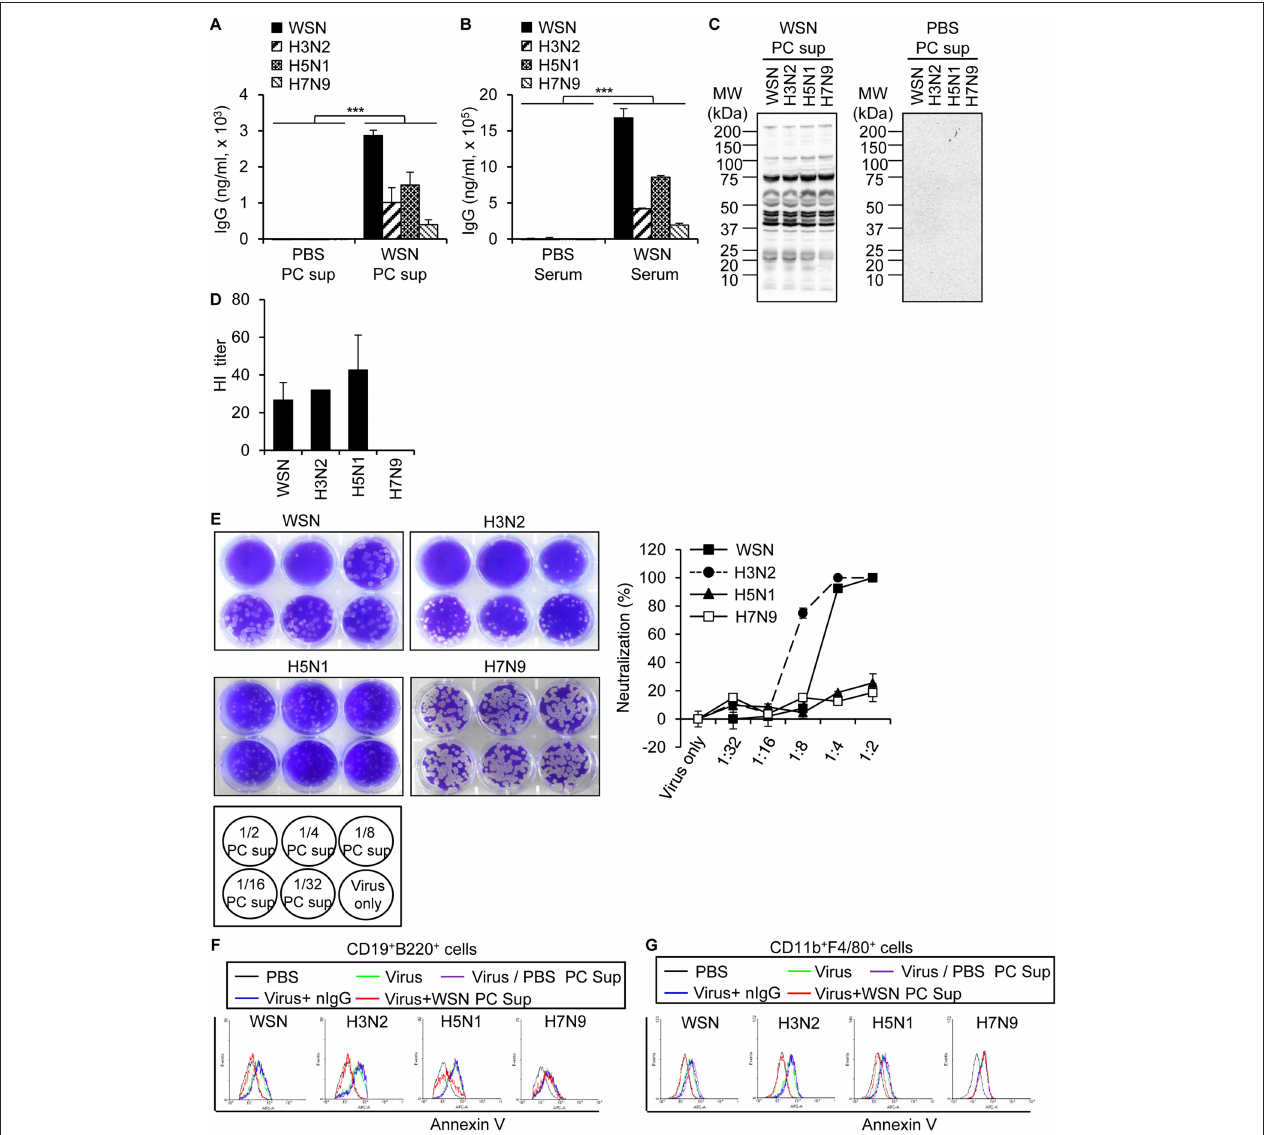
FIGURE 6 | Cross reactivity of A/WSN/1933 virus-induced antibody to other influenza A viruses. Peritoneal cavity fluids and sera were collected from BALB/c mice ( n = 5/group) 14 days after intraperitoneal inoculation with 5 × 10 6 pfu of A/WSN/1933 virus. (A,B) Amounts of IgG cross-reactive against other influenza A viruses in peritoneal cavity fluids (A) and sera (B) obtained from A/WSN/1933 virus-inoculated mice were quantified by ELISA. *** p < 0.0005. (C) Identification of cross-reactivity by western blotting. Influenza protein samples from influenza A viruses were separated by SDS-PAGE and then examined by western blot analysis with the peritoneal cavity fluids of A/WSN/1933 virus-inoculated (WSN PC sup) or PBS-inoculated (PBS PC sup) mice. (D) Identification of cross reactivity by a hemagglutination inhibition (HI) assay. HI titers of the peritoneal cavity fluids from A/WSN/1933 virus-injected BALB/c were performed with 4 hemagglutination units (4HA) of each influenza A virus. (E) Identification of cross-reactivity by virus neutralization assay. The ability of the peritoneal cavity fluids of A/WSN/1933 virus-inoculated mice to neutralize the plaque forming ability of each influenza A virus was determined by counting plaques and calculating the neutralization percentage. (F,G) PBS-injected peritoneal cavity fluids (PBS PC Sup), A/WSN/1933 virus-inoculated peritoneal cavity fluids (WSN PC Sup), or mouse normal IgG (nIgG) were incubated with the indicated influenza A viruses for 1h and then incubated with peritoneal cells. (F) After 72h of incubation, the cells were stained with fluorescence-conjugated antibodies (CD19, B220) and Annexin V and then analyzed by flow cytometry. Annexin V-positive B cells are represented in histograms. (G) After 72h of incubation, the cells were stained with fluorescence-conjugated antibodies (CD11b, F4/80) and Annexin V and then analyzed by flow cytometry. Annexin V-positive macrophages are represented in histograms. PC Sup, Peritoneal cavity fluids. WSN, A/WSN/1933 (H1N1). H3N2, A/Hongkong/4801/2014 (H3N2). H5N1, rIETR CVV (H5N1). H7N9, NIBRG-268M (H7N9). (H3N2) virus infection. Marked infiltration of T cells